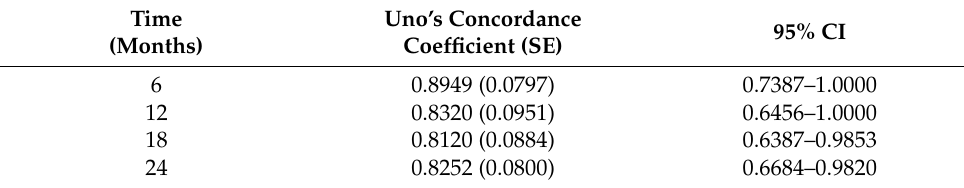
Figure 3. Time-dependent AUCs and 95% confidence intervals. Table 3. Uno’s concordance coefficient for the multivariate model at different